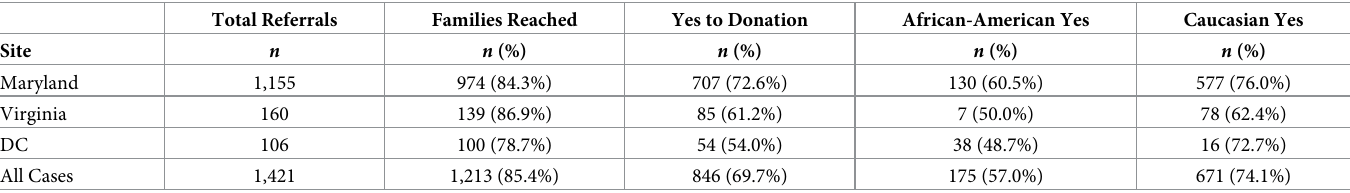
Table 1. Postmortem human brain donation referrals and cases consented by medical examiner and